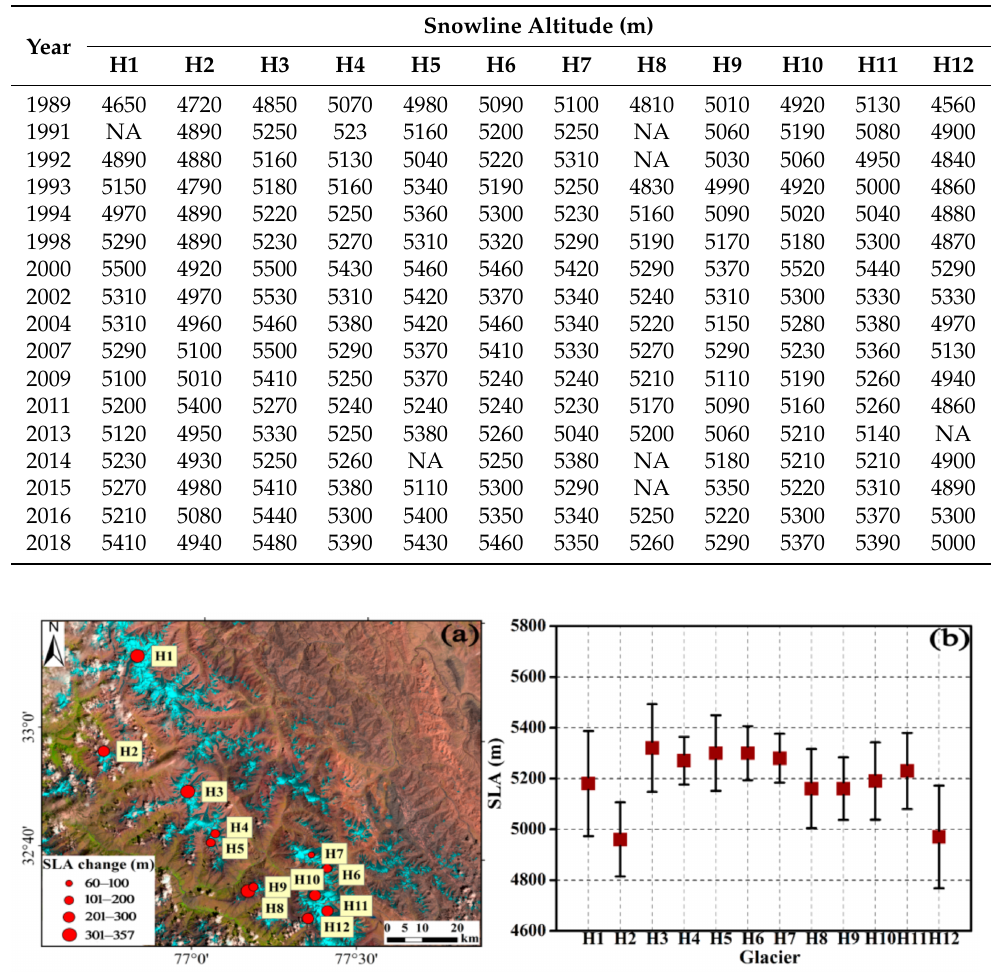
Figure 10. ( a ) SLA changes and ( b ) mean SLA for the12 analyzed glaciers across the Western Himalayas during the 1989–2018 period. The error bars in ( b ) represent one standard deviation from the